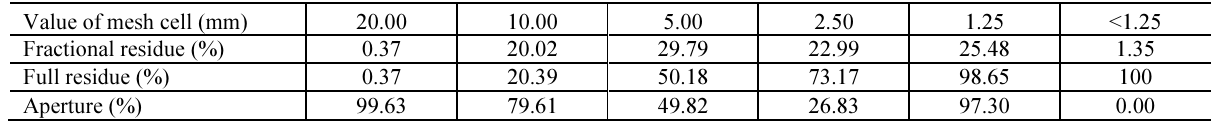
Table 1. Particle size distribution of EPS inclusions Value of mesh cell (mm)